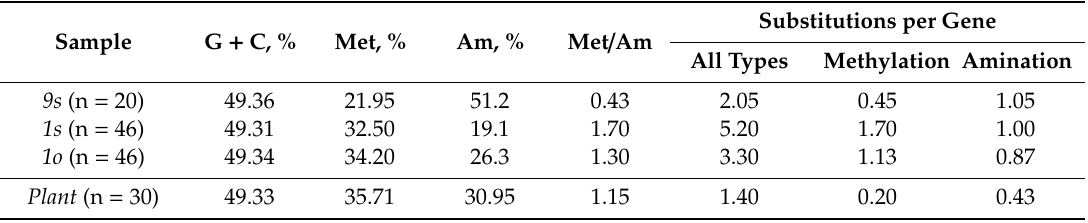
Table 3. GC content and characteristics of nucleotide substitutions in the 18S rDNA clones of Panax ginseng cell